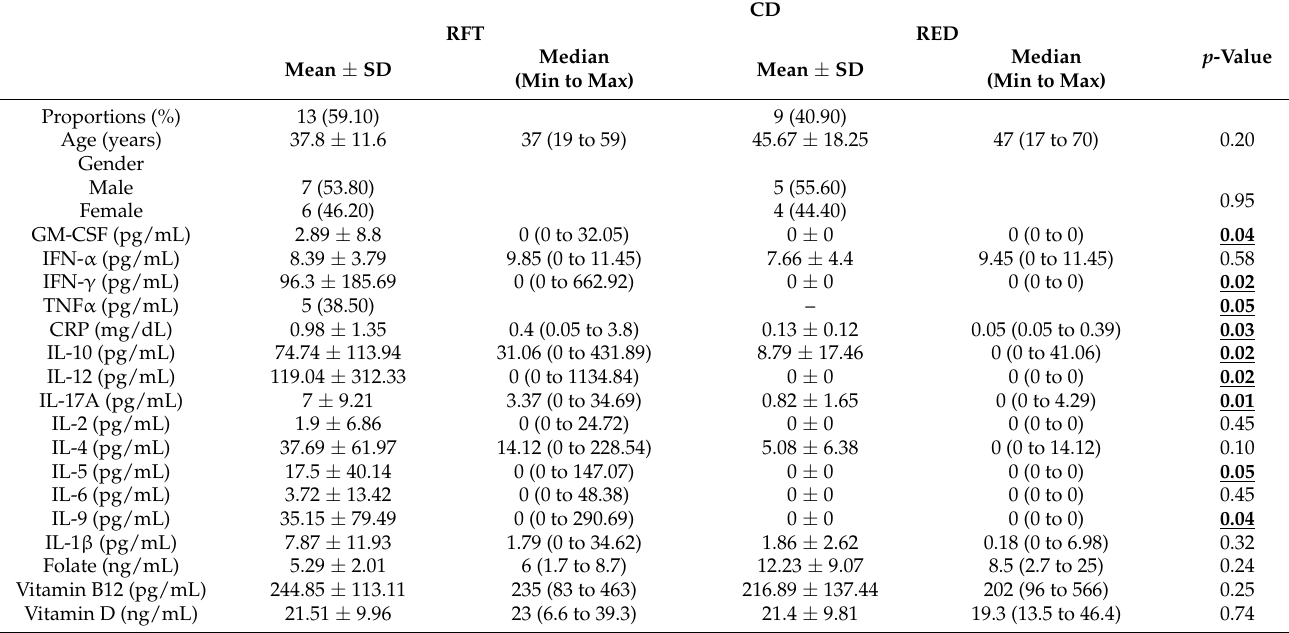
Table 4. Description of the whole sample at follow-up observation (T3) in CD patients, according to the type of treatment. (N: 22). Statistically significant differences ( p -value ≤ 0.05) are underlined in